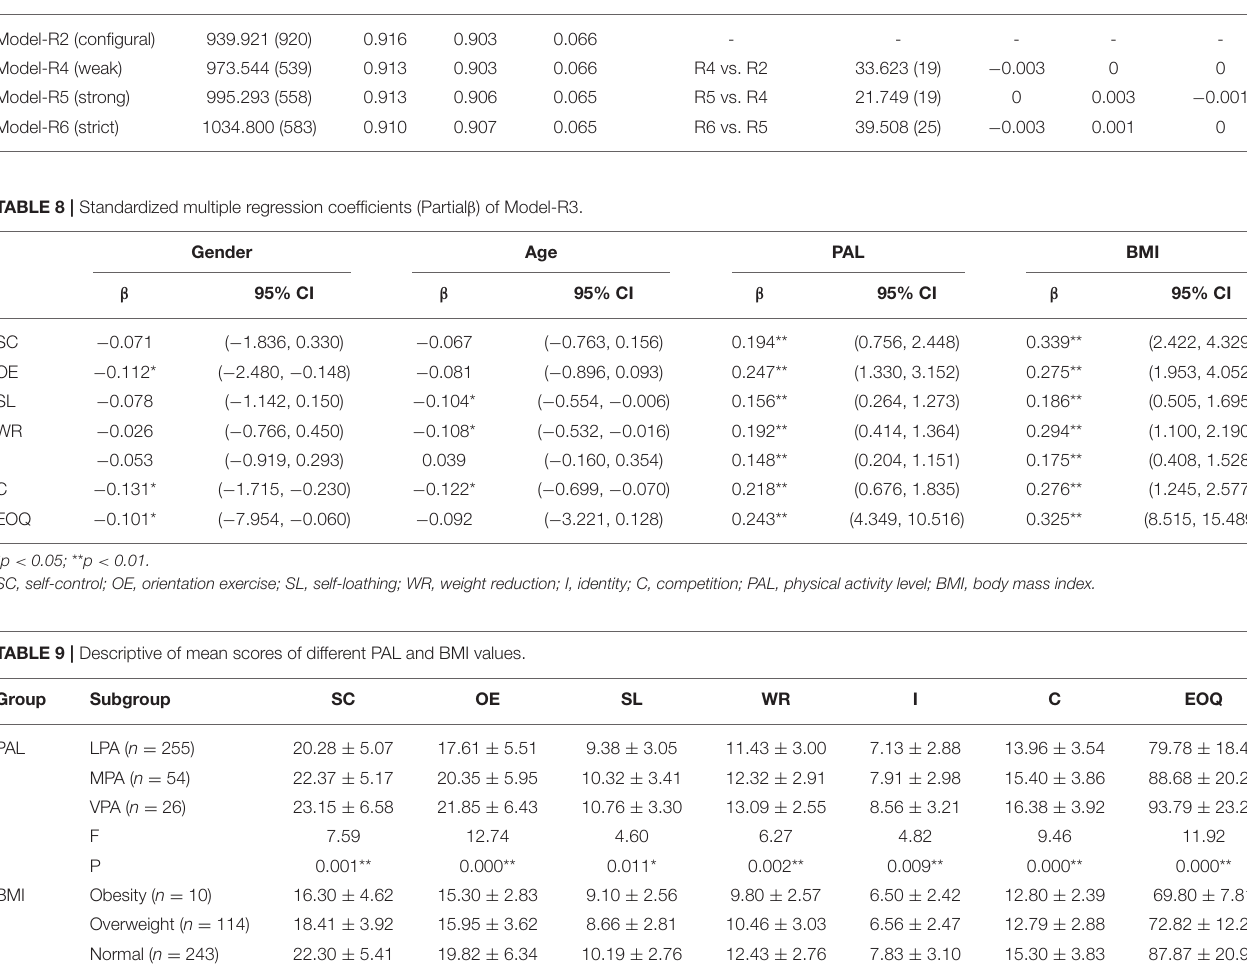
TABLE 7 | The tests of measurement invariance for abbreviated EOQ models. Model